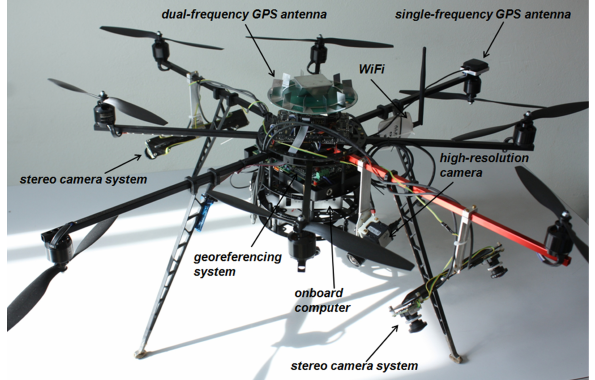
Figure 4: The UAV together with all the onboard mounted hard-